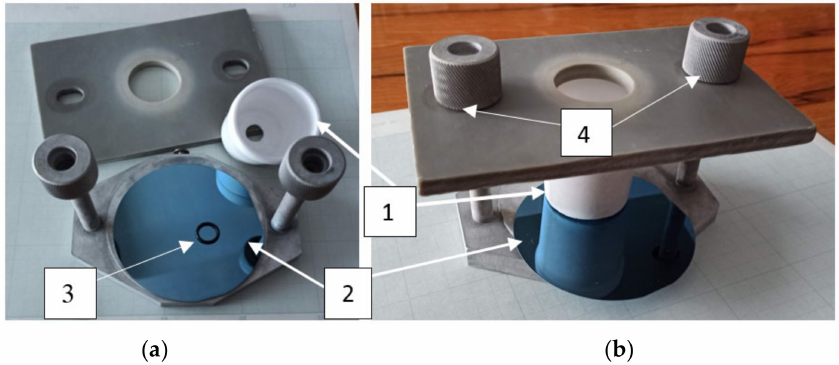
Figure 1. Device for local anodic etching. ( a ) disassembled cassette: 3—durite intermediate ring, 2—Si wafer (front (working) surface), ( b ) Cassette “assembled”: 1—Fluoroplastic container for electrolyte,